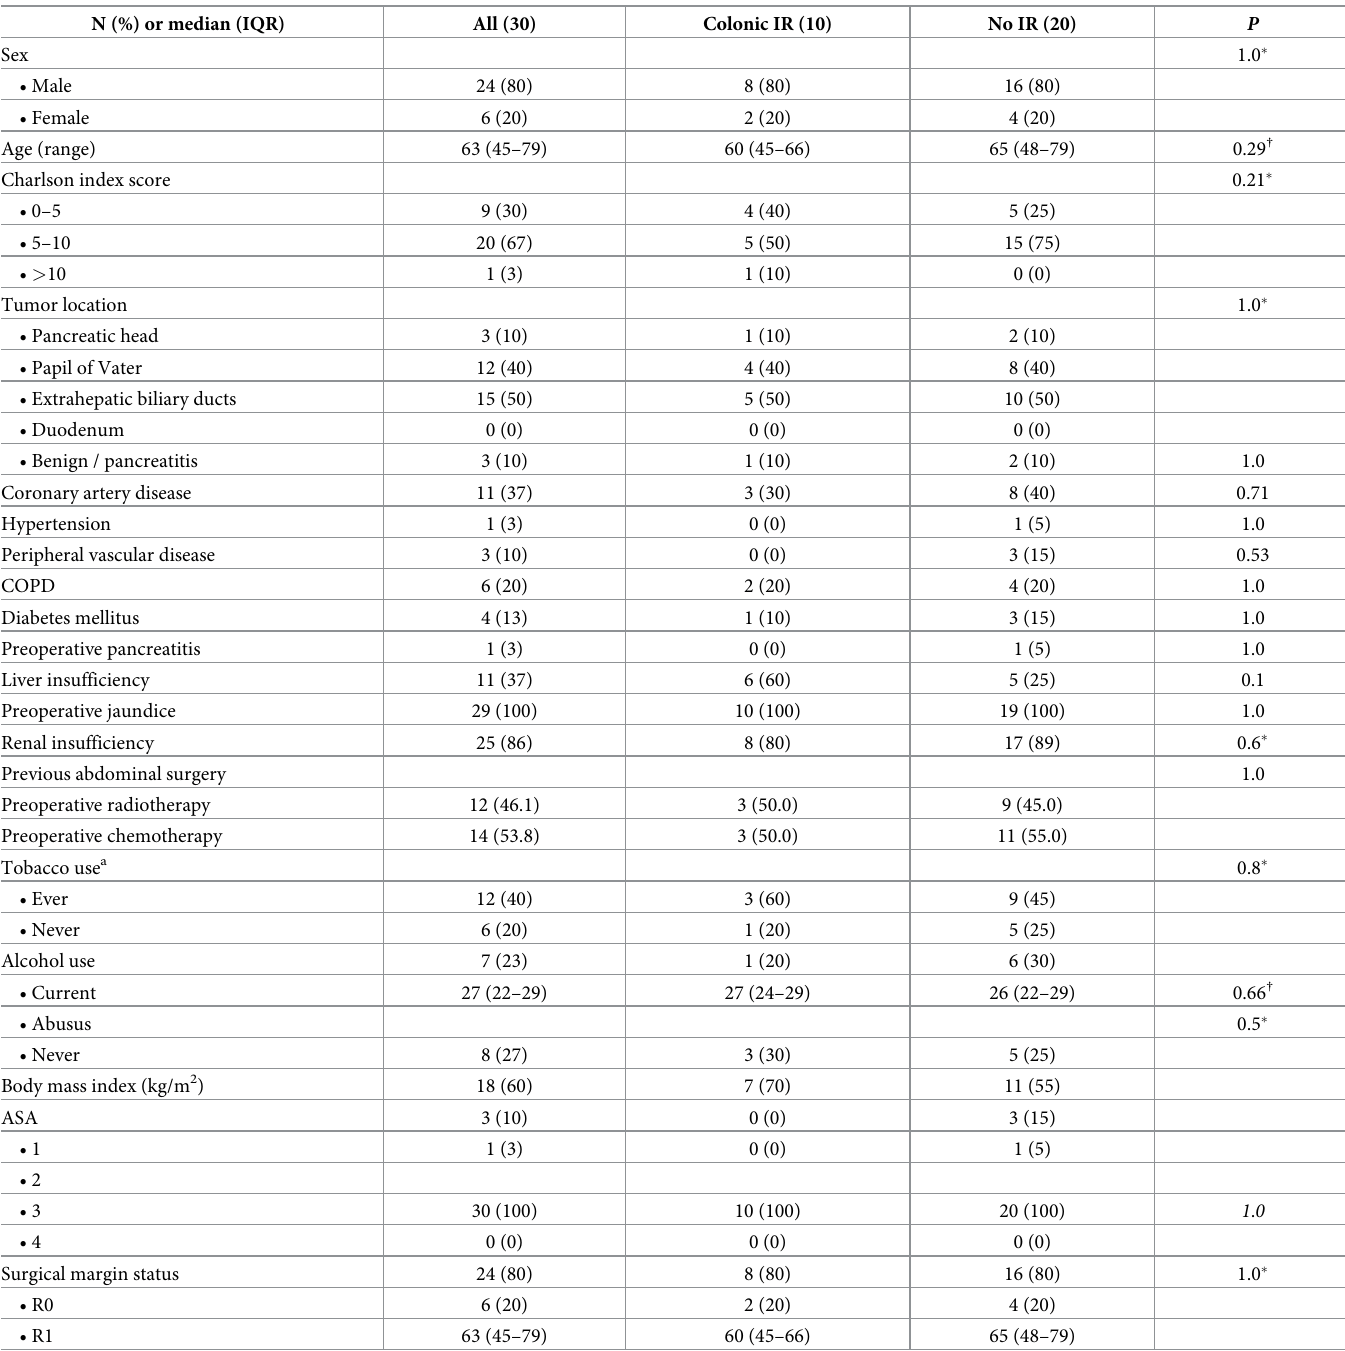
Table 2. Patient demographics and comorbid conditions of patients undergoing colorectal surgery with and without experimental in vivo colonic IR. N (%) or median